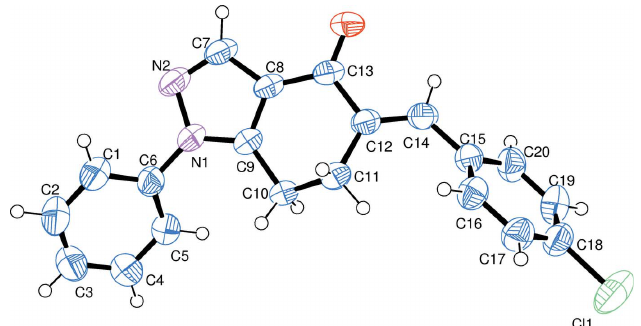
Figure 1 The molecular structure of the title compound, showing 50% probability displacement ellipsoids